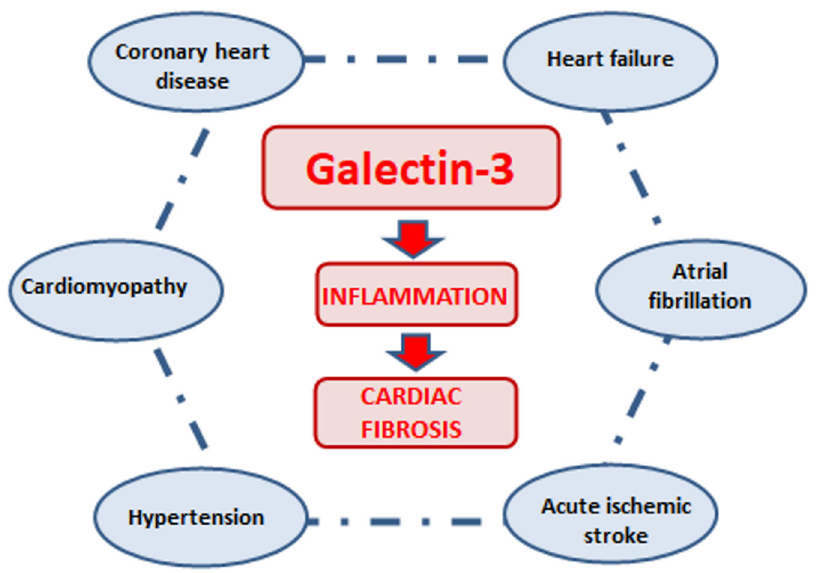
Figure 2. Galectin-3 and cardiovascular diseases.